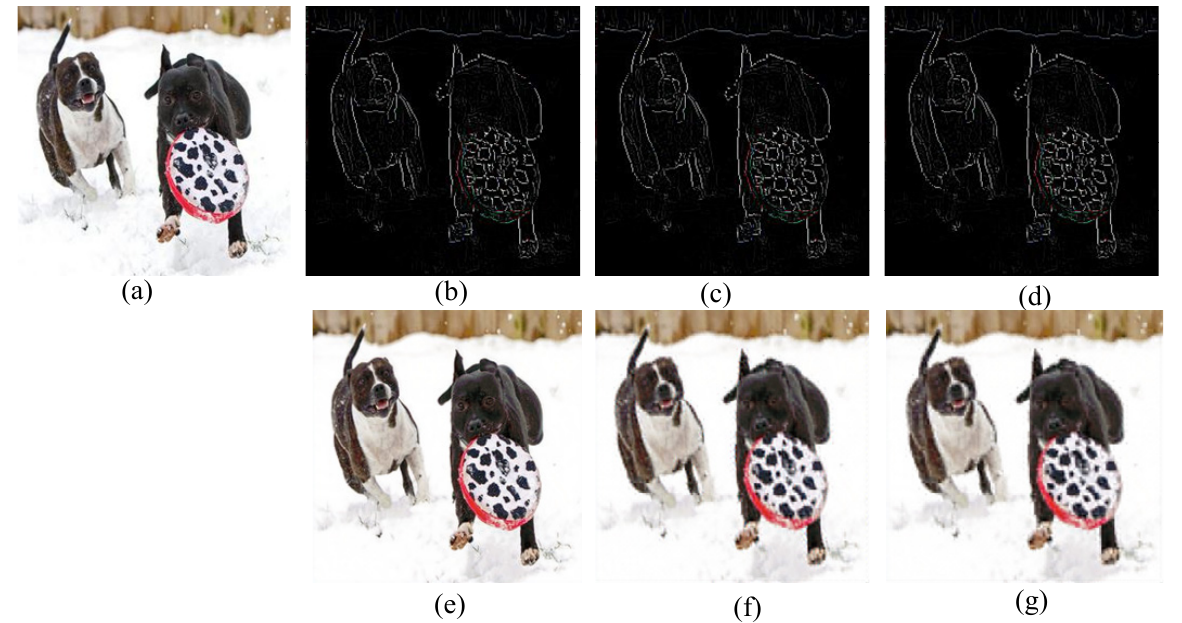
Figure 10. Images reconstructed based on different multiscale interest points feature maps at different scales. ( a ) Original image, ( b ) and ( e ) are the multiscale points feature maps and the corresponding reconstructed images when scale = 1; ( c ) and ( f ) are the multiscale singular maps and the corresponding reconstructed images when scale = 2; ( d ) and ( g ) are the multiscale singular maps and the corresponding reconstructed images when scale = 3. Table 4. Average number of interest points of the reconstructed images at different scales and their corresponding image PSNR, MSE, MSSIM, and ERGAS values.